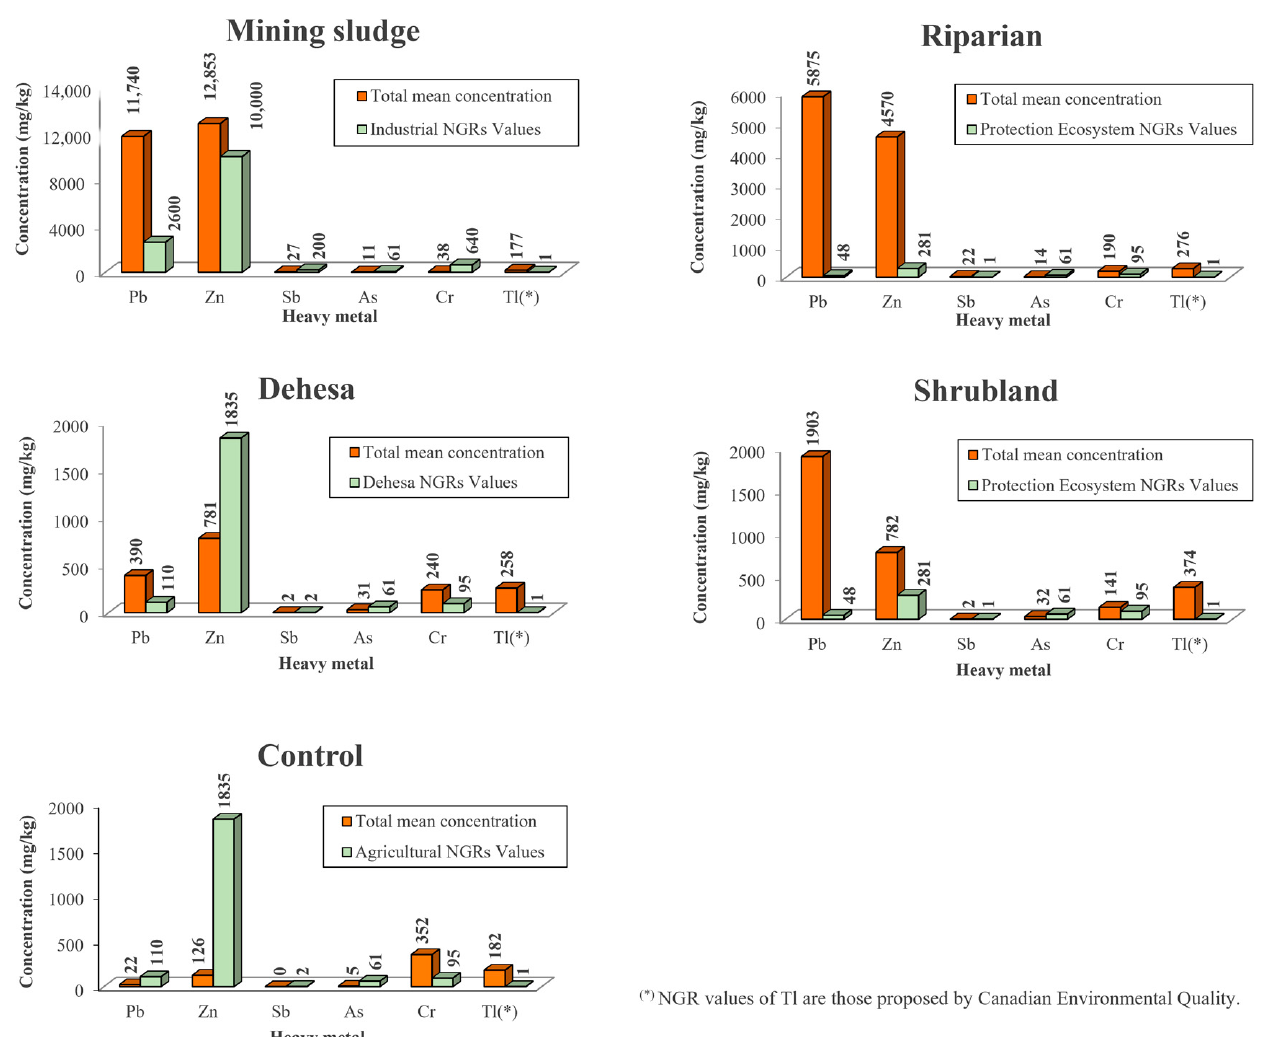
Figure 3. Total mean concentrations of the metals studied versus values for the NGR (Generic Reference Levels) in each of the zones. Mining sludge (n = 3), shrubland (n = 4), riparian (n = 12), dehesa (n = 21), control (n = 3).